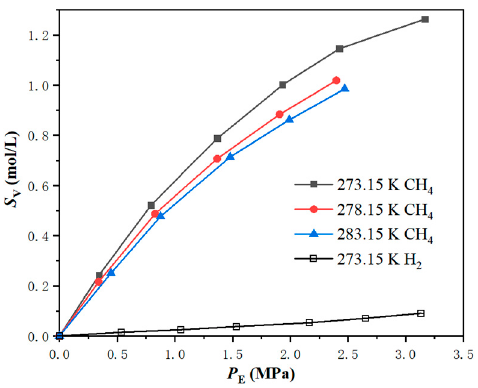
Figure 3. Solubility of CH 4 and H 2 in the slurry (ZIF-8 20 wt% + ethylene glycol 16 wt% + water 64 wt%) at different temperatures.